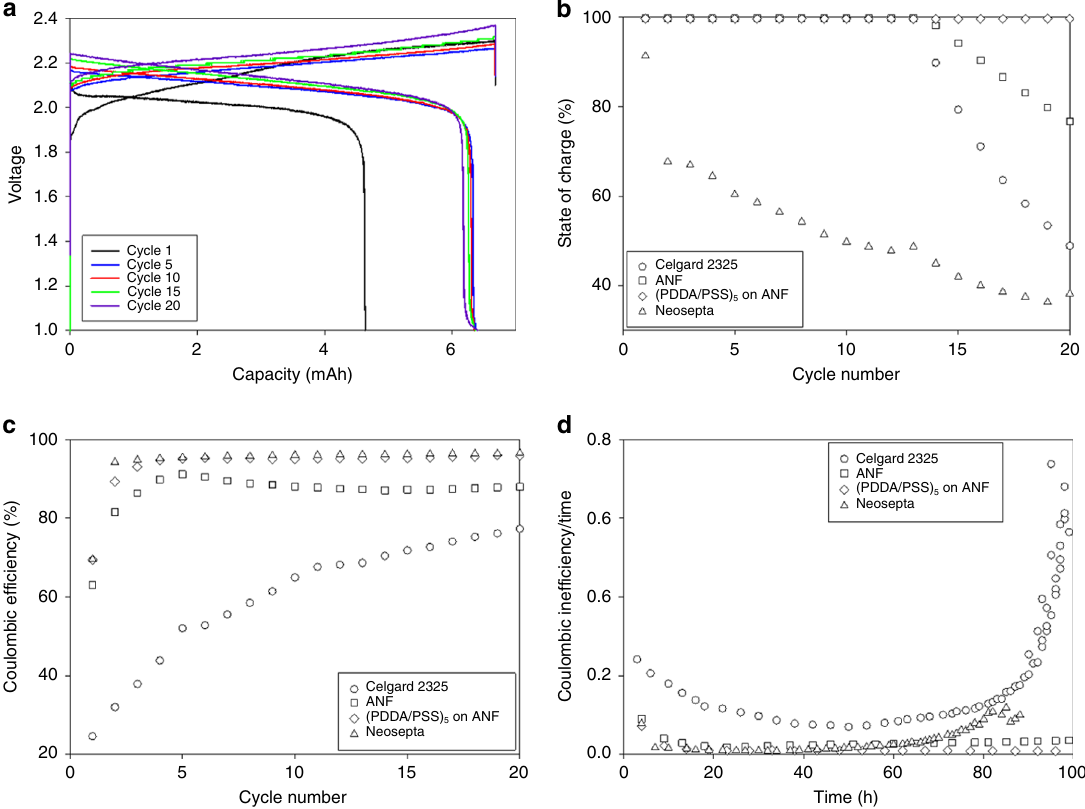
Fig. 3 Comparison of nonaqueous vanadium fl ow battery performance with ANF and Celgard separators and Neosepta membrane. a Voltage pro fi les for an all vanadium acetylacetonate fl ow cell with poly(diallyldimethylammonium chloride)/poly(styrene sulfonate) (PDDA/PSS) 5 on aramid nano fi bre (ANF) as the separator; b normalized charge capacity for Celgard 2325, ANF, (PDDA/PSS) 5 on ANF and Neosepta; c coulombic ef fi ciencies per cycle; and d coulombic inef fi ciency (CIE)/cycle time plotted against total time comparing the degradation rates of each separator/membrane material 2325 and Neosepta. V(acac) 3 served as the active species in the catholyte and anolyte, and the cells were cycled to 50% state-of- charge (SOC) at ~1 mA cm − 2 (C/5) to provide suf fi cient time per